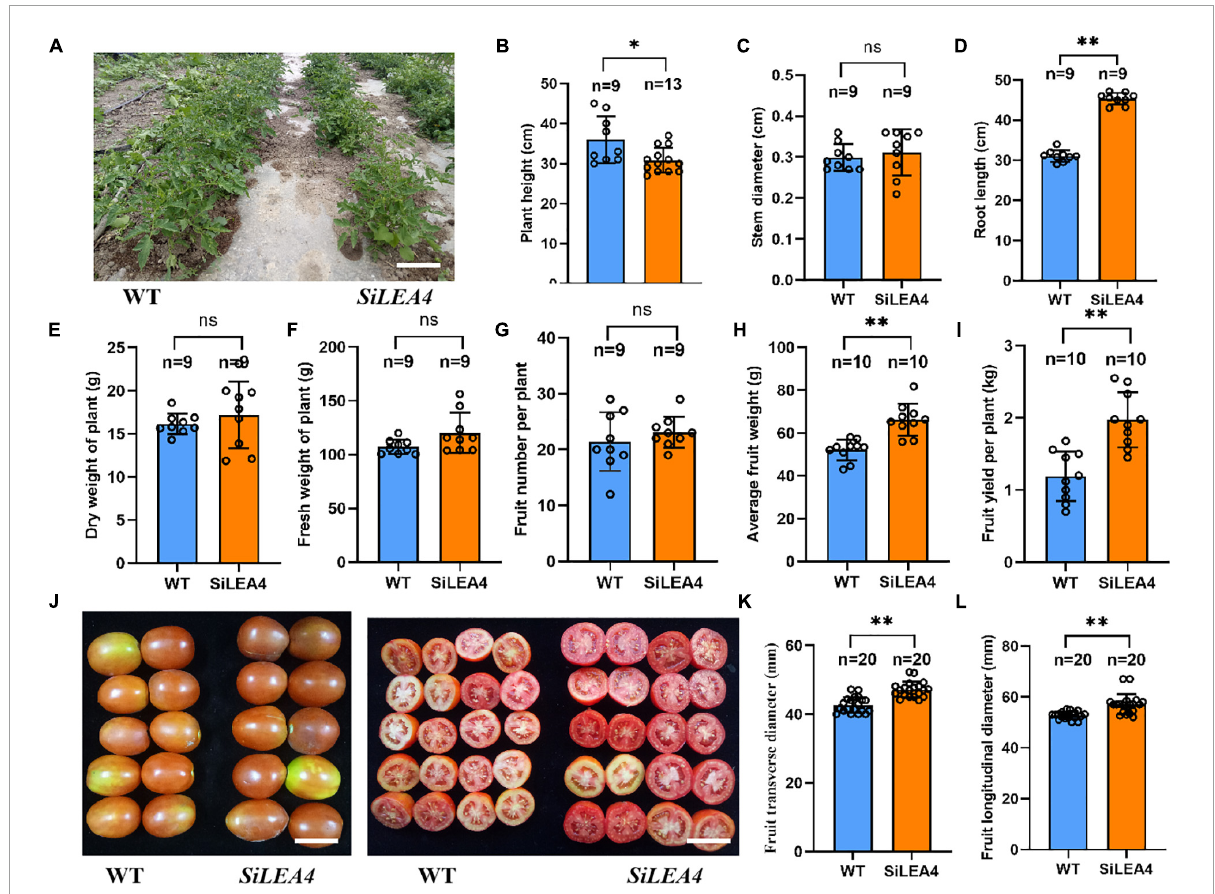
FIGURE7 Agronomic traits analysis of SiLEA4 transgenic tomato. (A) Performance of 8-week-old SiLEA4 transgenic and wild-type tomato plants in field. Bar = 25 cm. (B–F) Comparison of plant height, Stem diameter, root length, plant fresh and dry weight between SiLEA4 -transformed plants and wild-type plants. (G–I) Tomato yield of transgenic line and wild type. (J) The whole fruit appearance (left) and cross section (right) of transgenic lines and wild type. Bar = 50 mm. (K,L) Comparison of transgenic tomato fruit with wild-type tomato fruit in cross-sectional and longitudinal diameter. Error bars, mean ± SD. n = Number of plants. ns. no significant difference. The asterisks indicate a statistically significant difference (two-tailed Student’s t -test, ∗ P < 0.05, ∗∗ P <